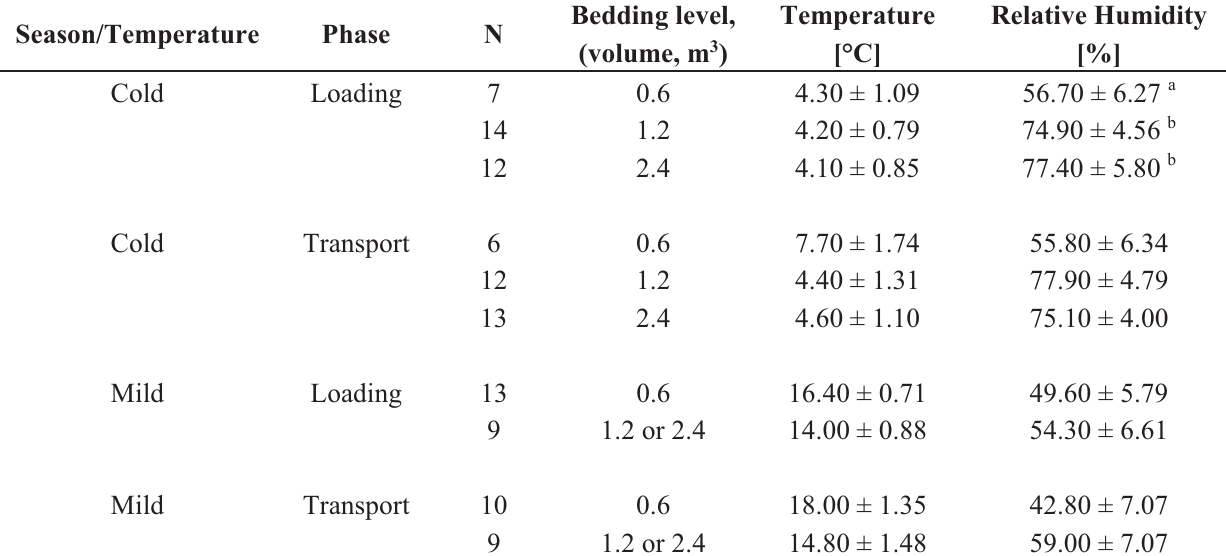
Table 1. Environmental temperature and relative humidity by season outside of trailer during loading and transport.